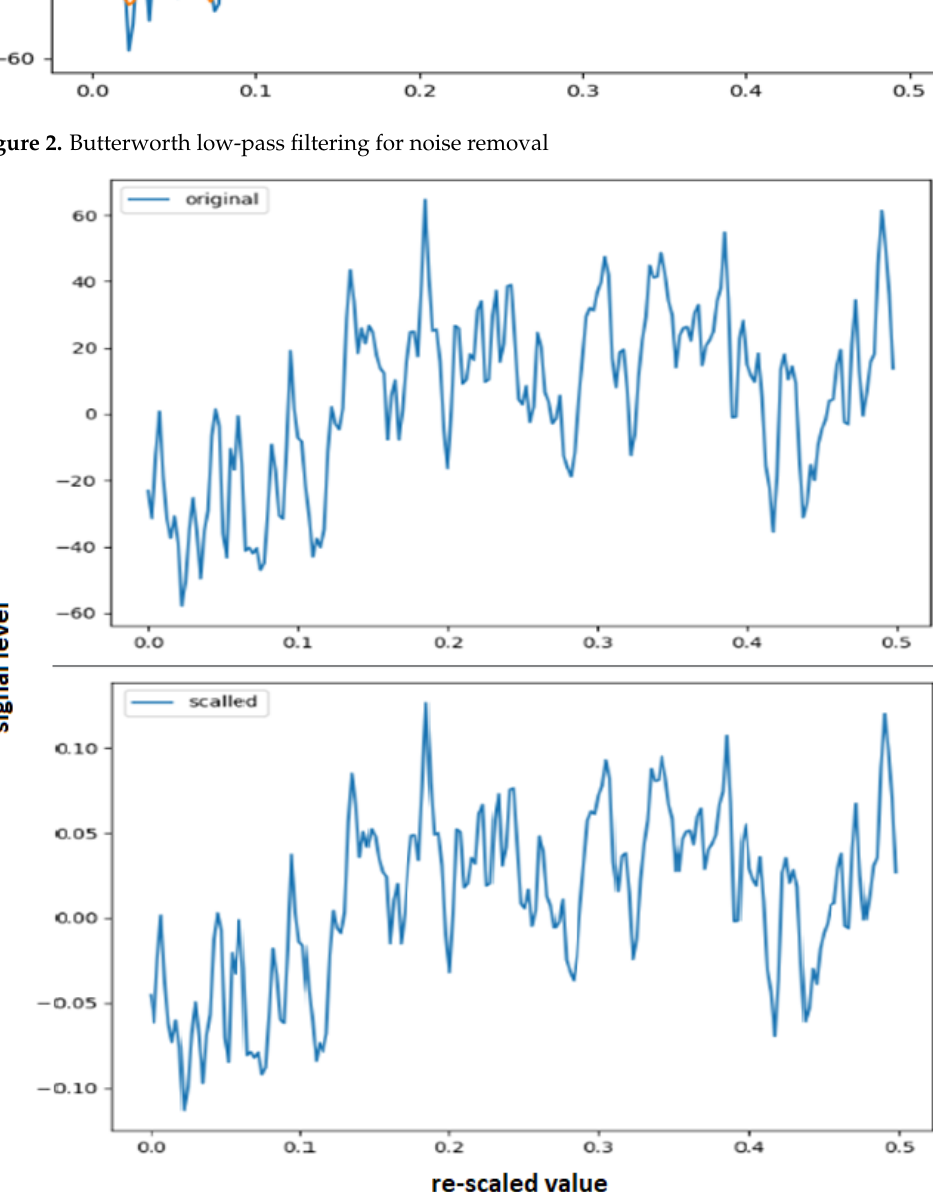
Figure 3. An example of an 0.5 s signal segment logged, showing the re-scaling with the sec- ondary